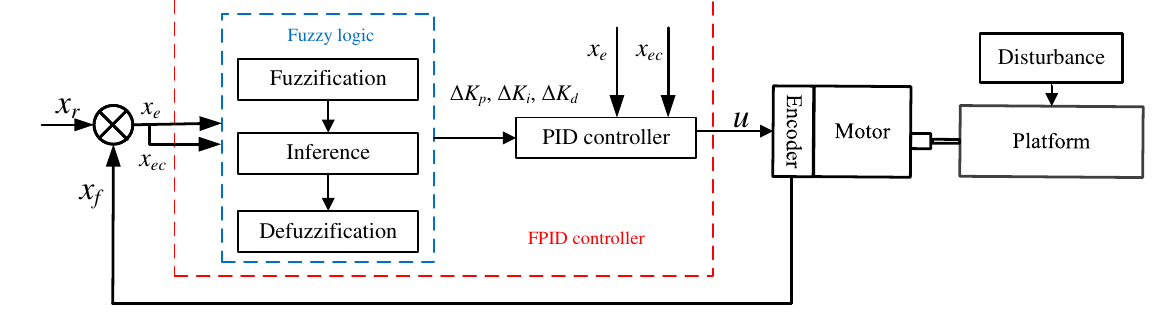
Figure 2. The structure of